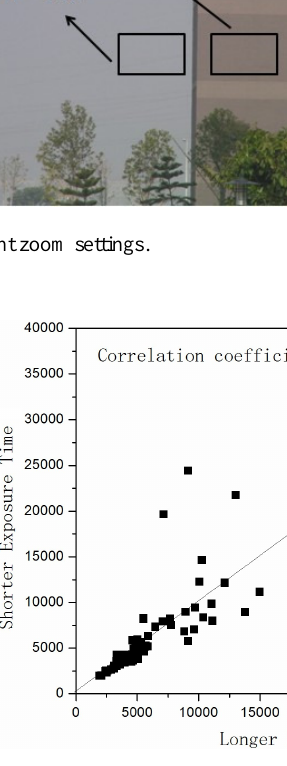
Fig. 7. Comparison between DOM-Vis results obtained at different exposure